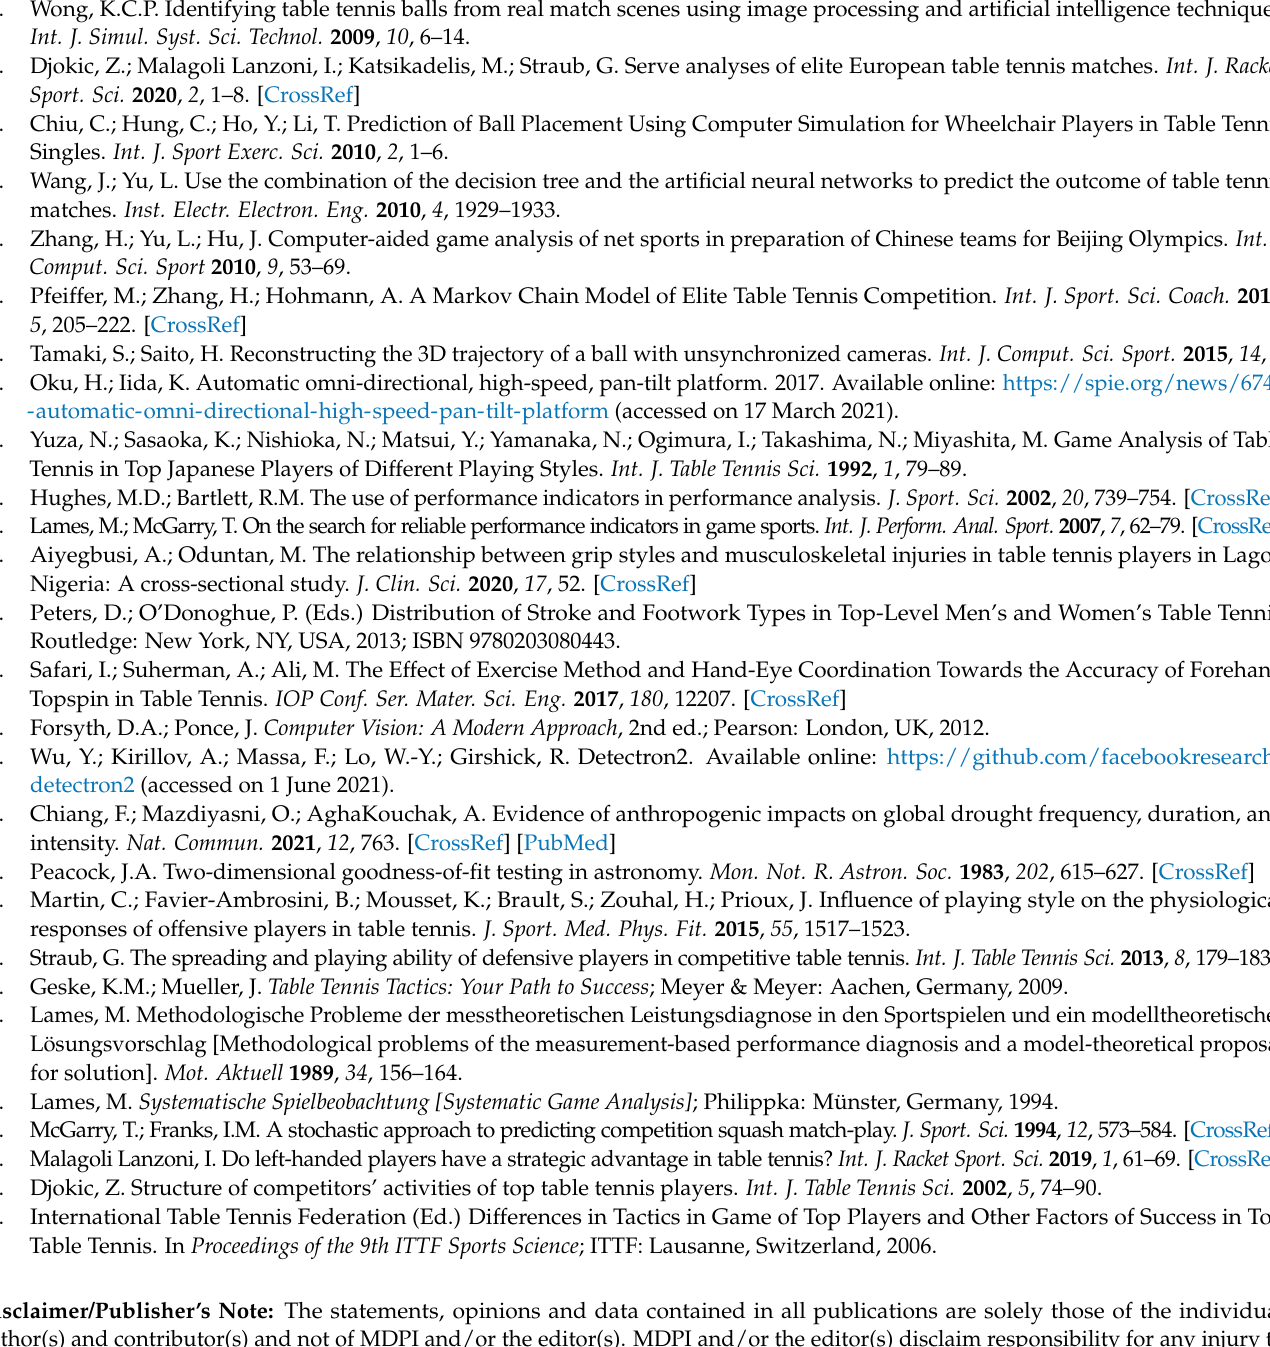
Table Tennis. In Proceedings of the 9th ITTF Sports Science ; ITTF: Lausanne, Switzerland, 2006. Disclaimer/Publisher’s Note: The statements, opinions and data contained in all publications are solely those of the